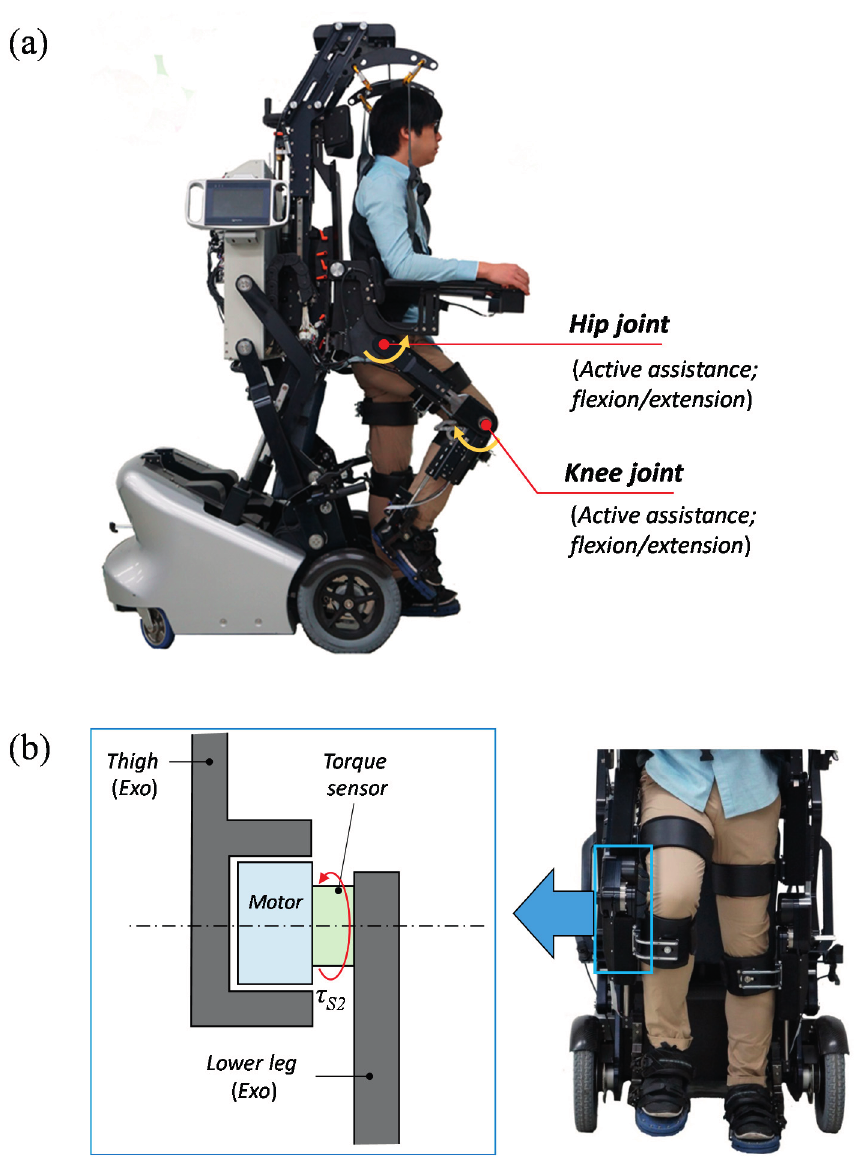
Figure 1. ( a ) Prototype of the EXOwheel robot; ( b ) Schematic diagram of the exoskeleton knee joint in the frontal